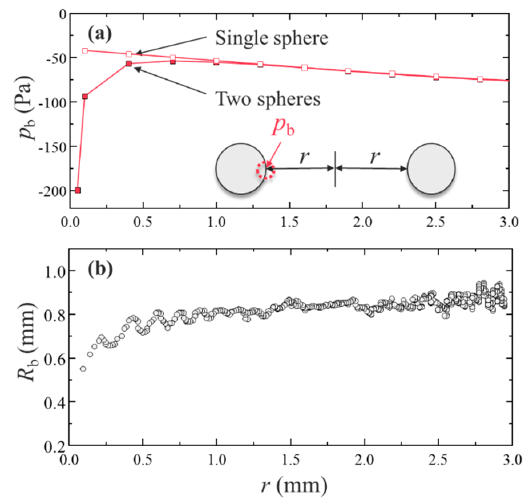
Figure 5. Acoustic radiation pressure at the edge when approaching a solid sphere: ( a ) Acoustic radiation pressure on the droplet edge using DPSM for a single and two solid spheres. The single sphere result is overlapped for comparison. ( b ) Droplet radii of curvature (left edge) from levitation to coalescence as a function of the distance between droplets obtained from Figure 3b.